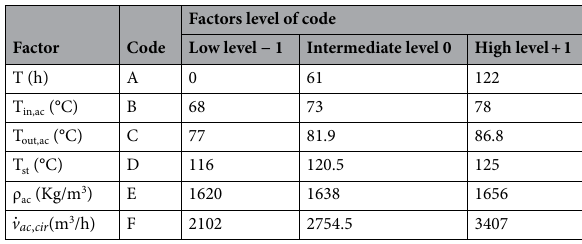
Table 3. Factors and factor levels for